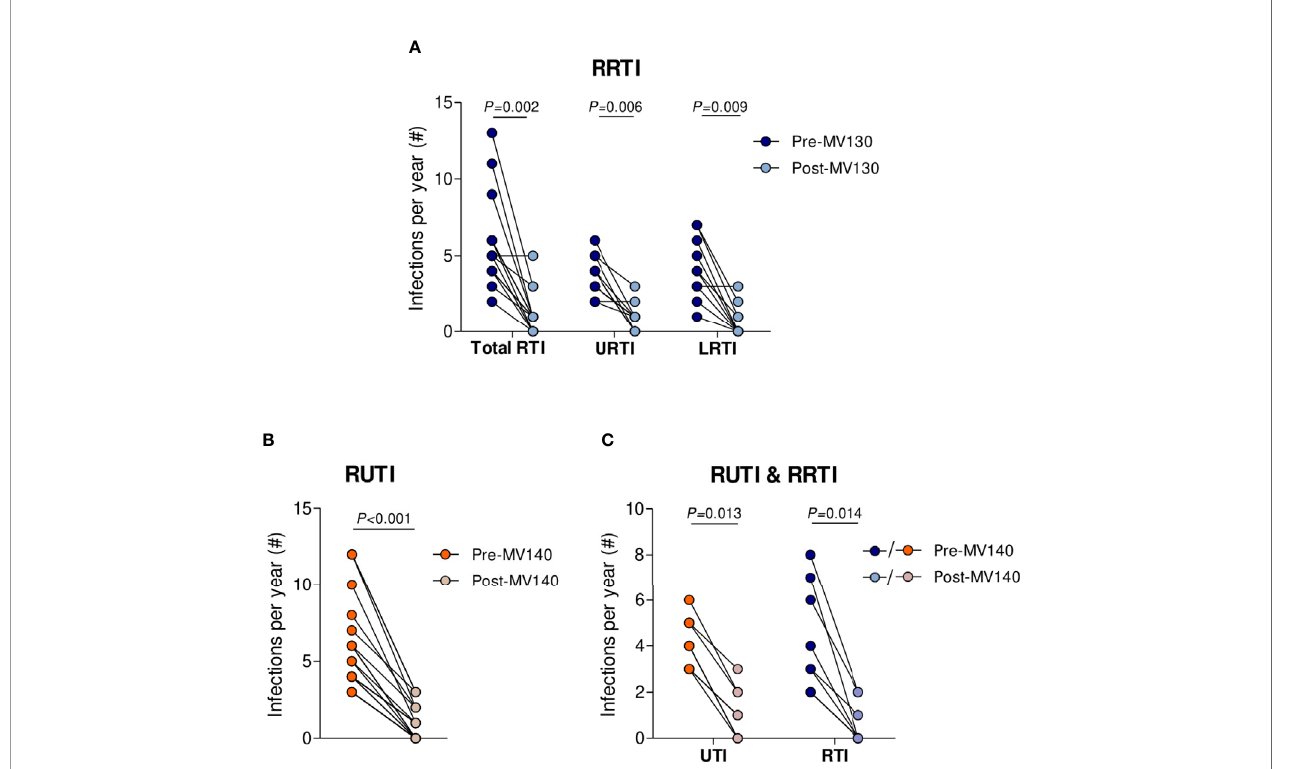
FIGURE 2 | MV140 and MV130 induce a signi fi cant fall-off in the incidence of recurrent respiratory and urinary infections. (A-C) Number of infectious episodes scored 1 year prior to vaccination and throughout 12 months after the initiation of immunotherapy (MV130 or MV140) in subjects suffering RRTI (A) , RUTI (B) or both (C) . RRTI: Recurrent respiratory tract infections, either upper (URTI), lower (LRTI) or both (total RTI); RUTI: Recurrent urinary tract infections. Data from 14 (A) , 19 (B) or 8 (C) subjects are shown. Lines link paired values. Normal distribution was evaluated using the Shapiro-Wilk test. P values were calculated using Wilcoxon signed- rank